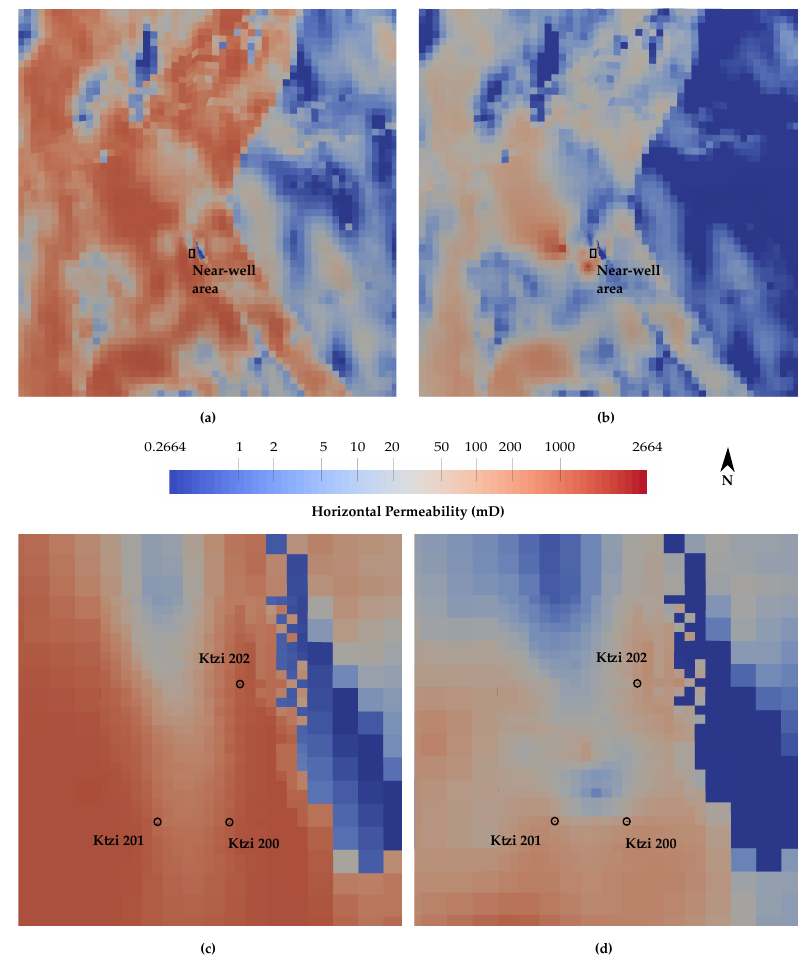
Figure 8. ( a ) Plan view of initial horizontal permeability distribution and ( b ) the revised one in the reservoir model far-field (5 km × 5 km, black rectangle indicates well locations). ( c ) Plan view of initial horizontal permeability distribution and ( d ) the revised one in the near-well area (distance between the wells Ktzi 201 and Ktzi 200 is 50 m). Fourth upper layer of simulation grid shown in all